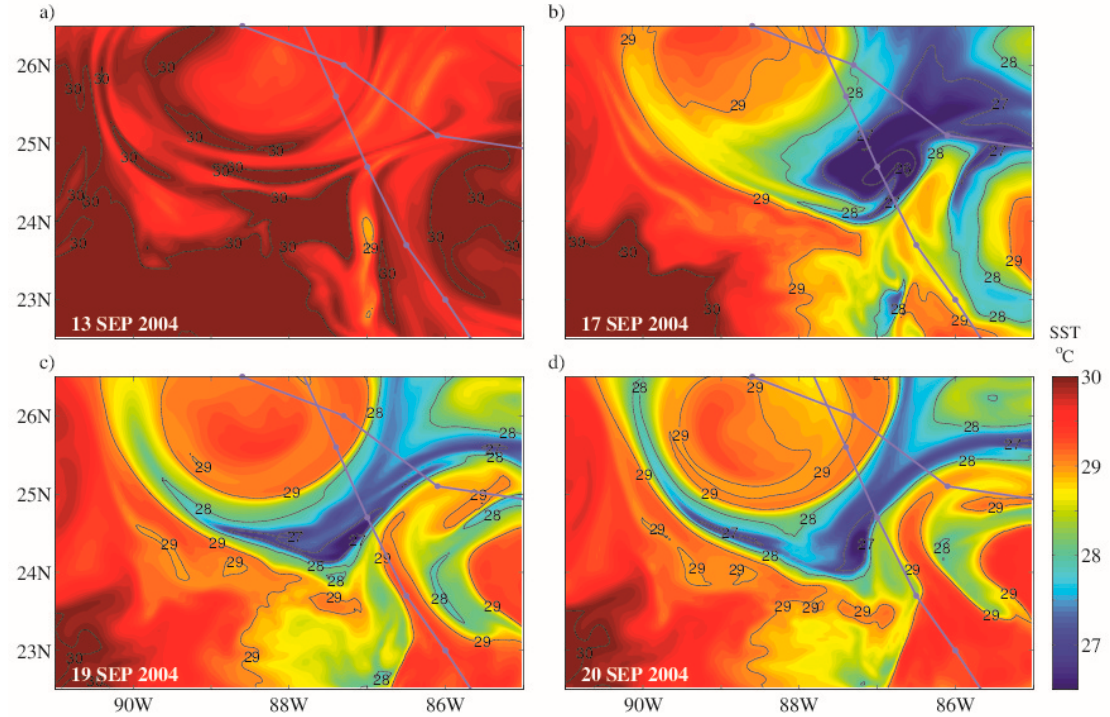
Figure 3. COAMPS-TC sea surface temperature ( ◦ C) between 85 ◦ -92 ◦ W and 22.5 ◦ –26.5 ◦ N. ( a ) 0000 UTC 13 September 2004. ( b ) 0000 UTC 17 September 2004. ( c ) 0000 UTC 19 September 2004. ( d ) 0000 UTC 20 September 2004. The Hurricane Ivan track is indicated by the dark purple line, with waypoints at each 0000 and 1200 UTC location.